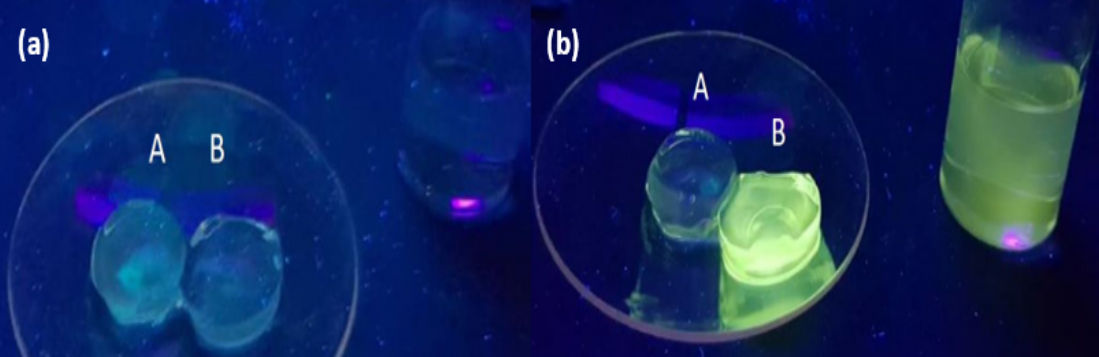
Figure 4. ( a ) Hydrogel pellets A and B (1.8 cm diameter). Sample A is a blank polyacrylamide control (PASS 0 logic gate). Sample B is embedded with 3 and exposed to a 0.1 M NaOH solution. ( b ) Sample B after exposure to 0.1 M HCl (beaker, right side). A yellow fluorescence is observed due to